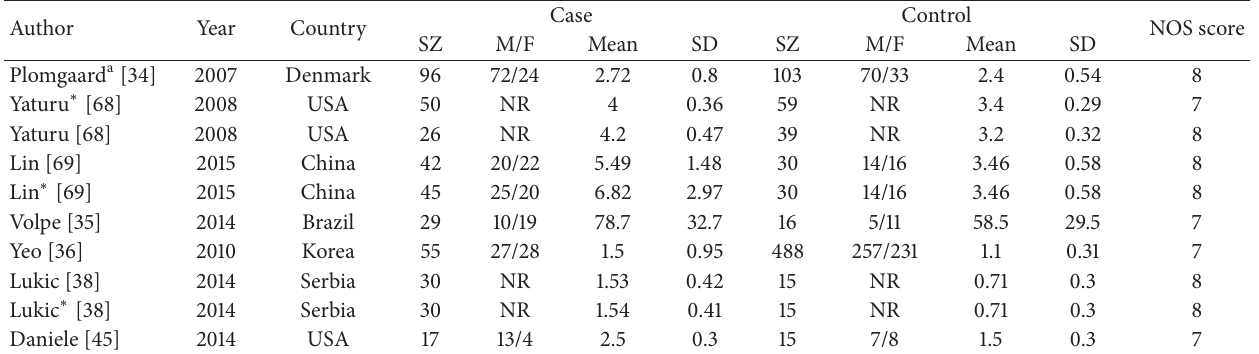
Table 3: Characteristics of studies about TNF- 𝛼 (pg/mL) included in this meta-analysis.